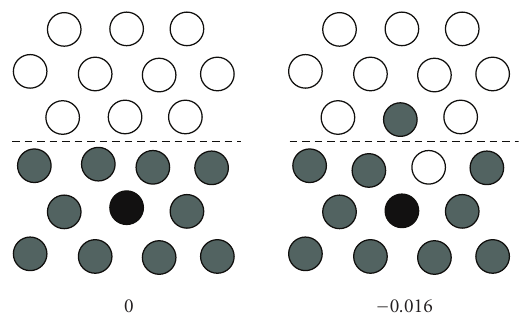
Figure 3: Configuration with a single Mo atom (black circle) located in an Al/U (open circle and grey circle, respectively) subinterface site. The di ff erence in energy (in eV) with respect to the reference state (left panel) is shown.